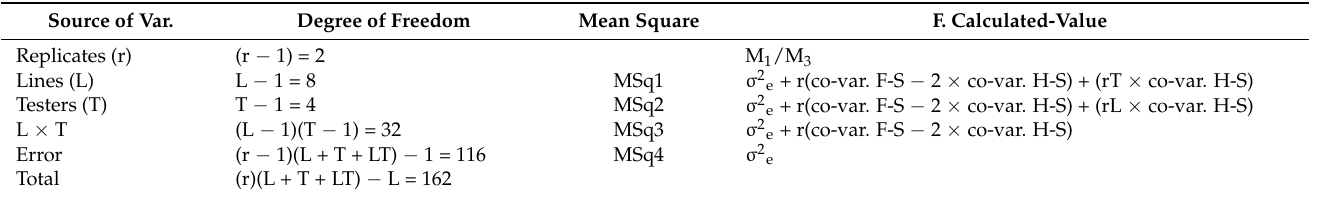
Table 2. Line by tester analysis of 59 wheat genotypes (including 14 parental and 45 crosses) under each test conditions (optimal vs.